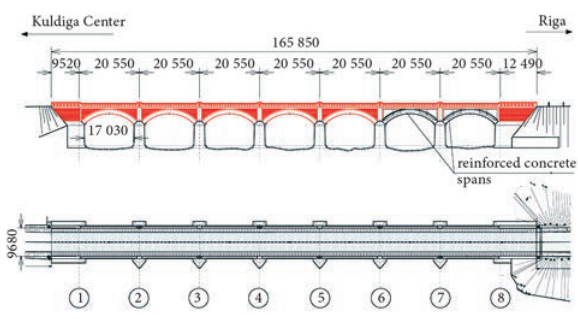
Fig. 2. Elevation and plan of the bridge